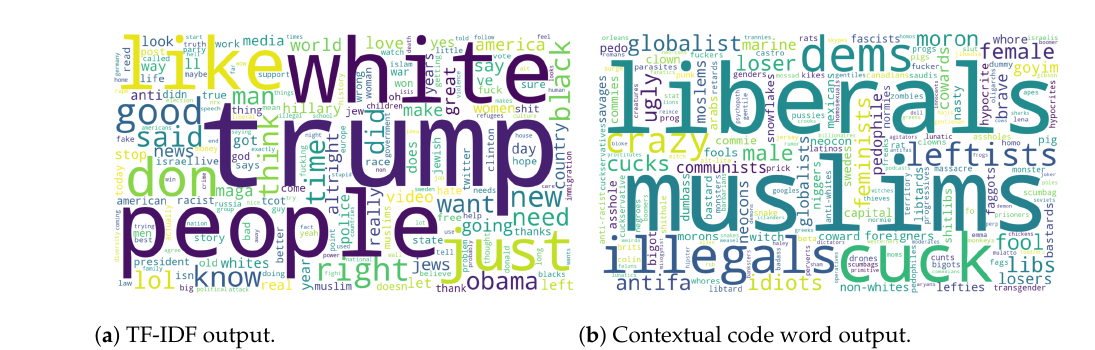
Figure 2. Surfaced